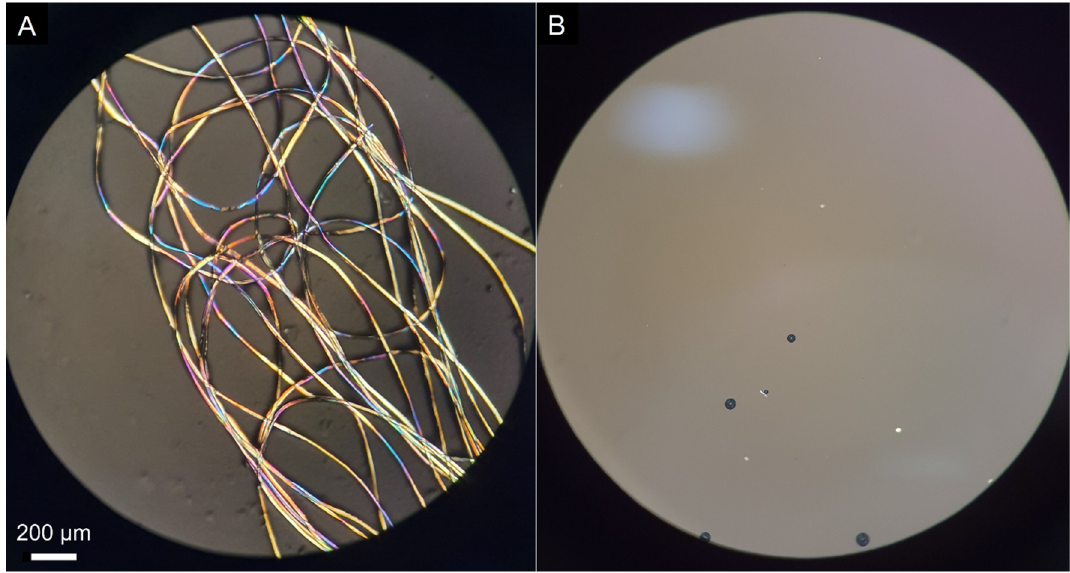
Figure 4. Optical microscope images of undissolved silk fibroin ( A ), and dissolved one ( B ) in AlB 2 Me 2 NAcO/DMSO.